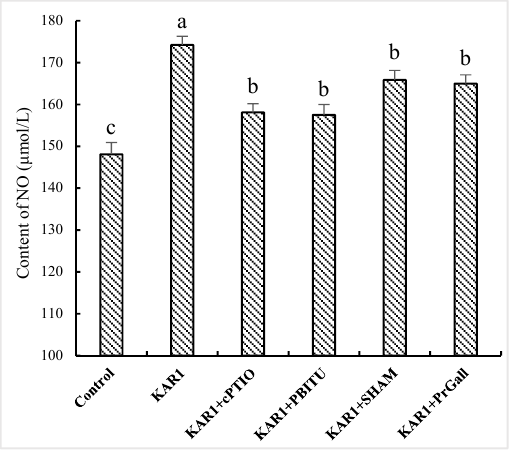
Figure 5. Effects of inhibitors on KAR 1 -induced NO generation in S. miltiorrhiza hairy root. S. miltiorrhiza hairy root treated with KAR 1 , and various inhibitors were harvested at 12 h after KAR 1 and JA contents were determined. Inhibitors were pretreated 1 h before treatment of KAR 1 . The control received vehicle solvent only. Data are means of three replicates ± SD. Different letters indicate significantly different values according to one-way ANOVA followed by Tukey’s test ( p <